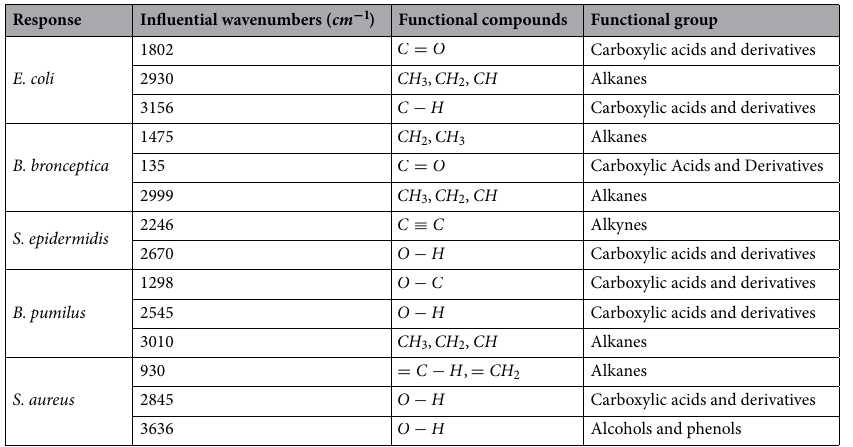
Table 3. By using the bootstrapping with LAR consistent influential wavenumbers for B. bronceptica, E. coli, S. epidermidis, B. pumilus and S. aureus are selected. The best-fitted model’s powerful regression coefficients for each bacteria are presented. Furthermore, for each model, the influential compound assignment and respective group is indicated.